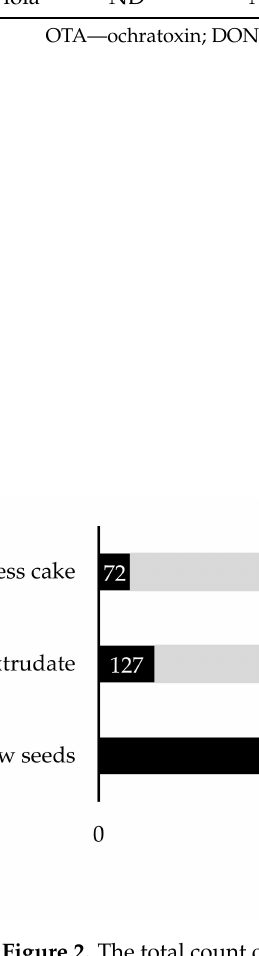
Figure 2. The total count of mould and yeast colonies in raw soybean seeds of the Petrina variety and in the feed products made from these seeds. The percentage difference was calculated with reference to the raw seeds in which the count of mould colonies was assumed to be